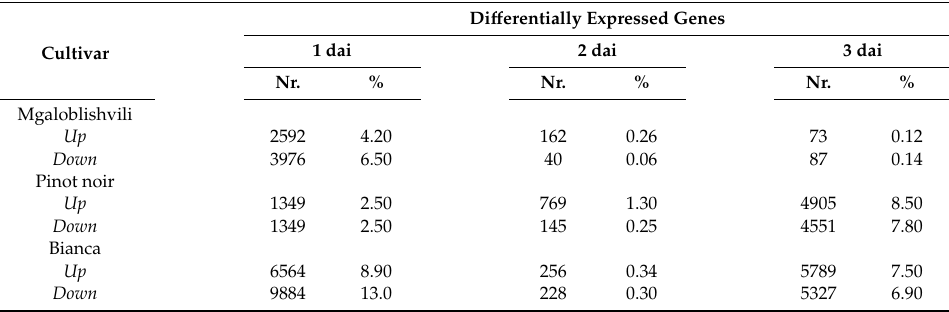
Table 3. Overview of di ff erentially expressed genes (Nr. and %) detected in Mgaloblishvili, Pinot noir, and Bianca leaves inoculated with Plasmopara viticola , at three di ff erent time points (1, 2, and 3 dai), based on the de novo transcriptome. dai: day after